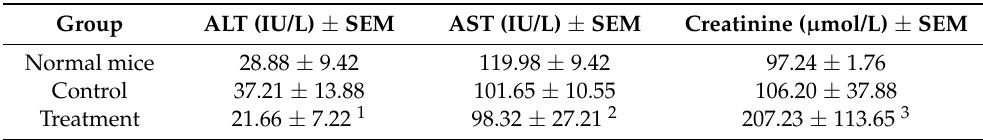
Table 9. Serum ALT, AST levels (IU/L), and Serum creatinine levels ( µ mol/L) for treatments, control, and normal untreated mice